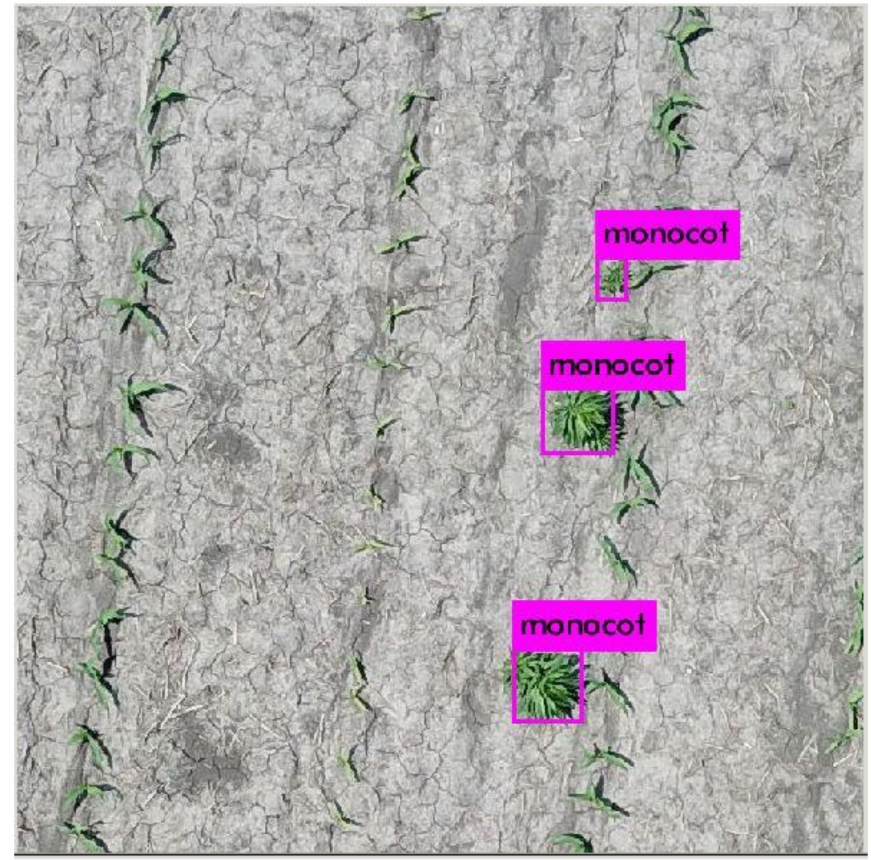
Figure 9. Monocot weed detection test set result from the YOLOv3 training on Image Set 2. Due to the physical differences in size and shape of the monocot weeds to the V1-stage corn (also a monocot), this class AP was significantly better than the dicot weeds, which looked more similar to the early season